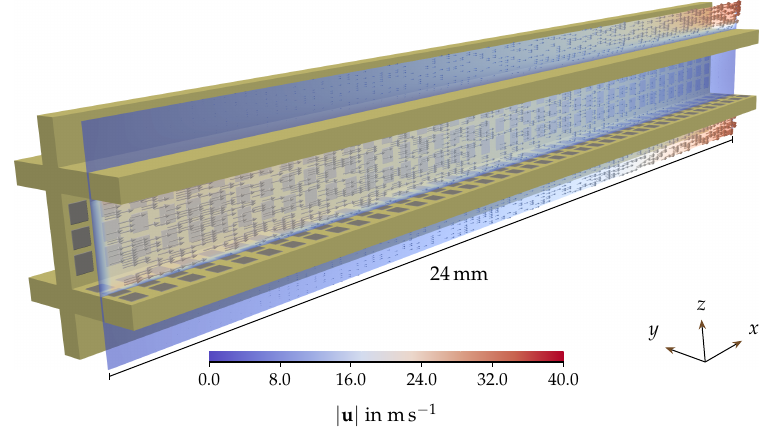
Figure 22. Flow field with fragmented PM layer assuming a height of d z = 21.0µm in gray. Dark yellow structures represent porous filter substrate. Colour scale indicates local velocity magnitude.